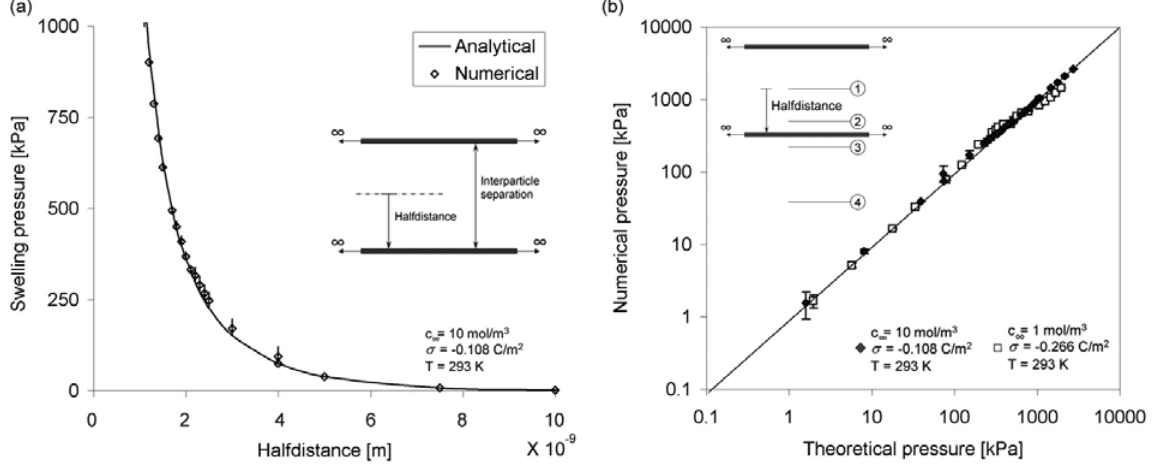
Fig. 3 – Model validation: (a) Analytical and numerical swelling pressure for the 1D case (b) Comparison between numerical and theoretically computed swelling pressures for different background electrolyte concentrations and surface charges; the error bars correspond to different tensor boxes